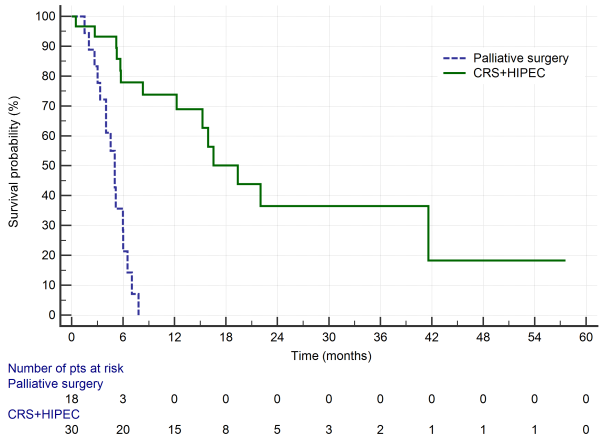
Figure 2. Overall survival of GC patients with PM treated with CRS + HIPEC vs. palliative surgery.